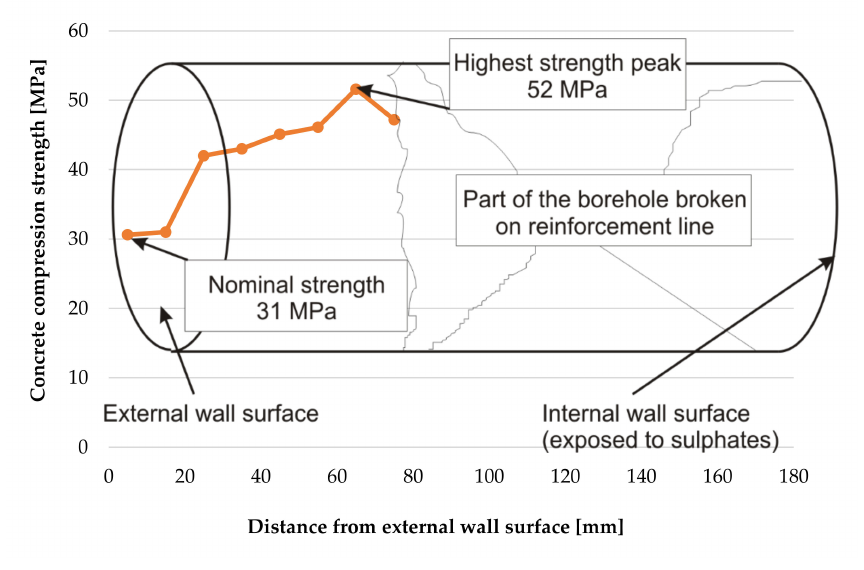
Figure 9. Change of concrete strength across the tank wall tested on borehole No.